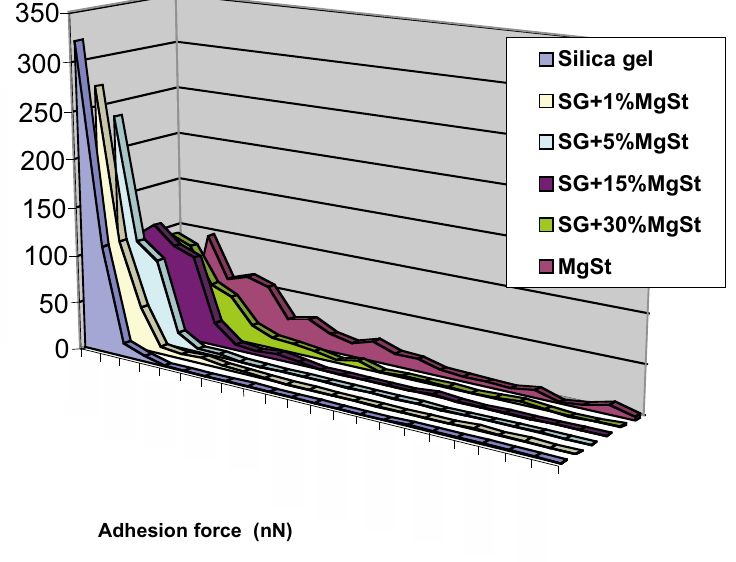
Fig. 9 CM-AFM adhesion force distribution obtained with 450 analyses for different particulate